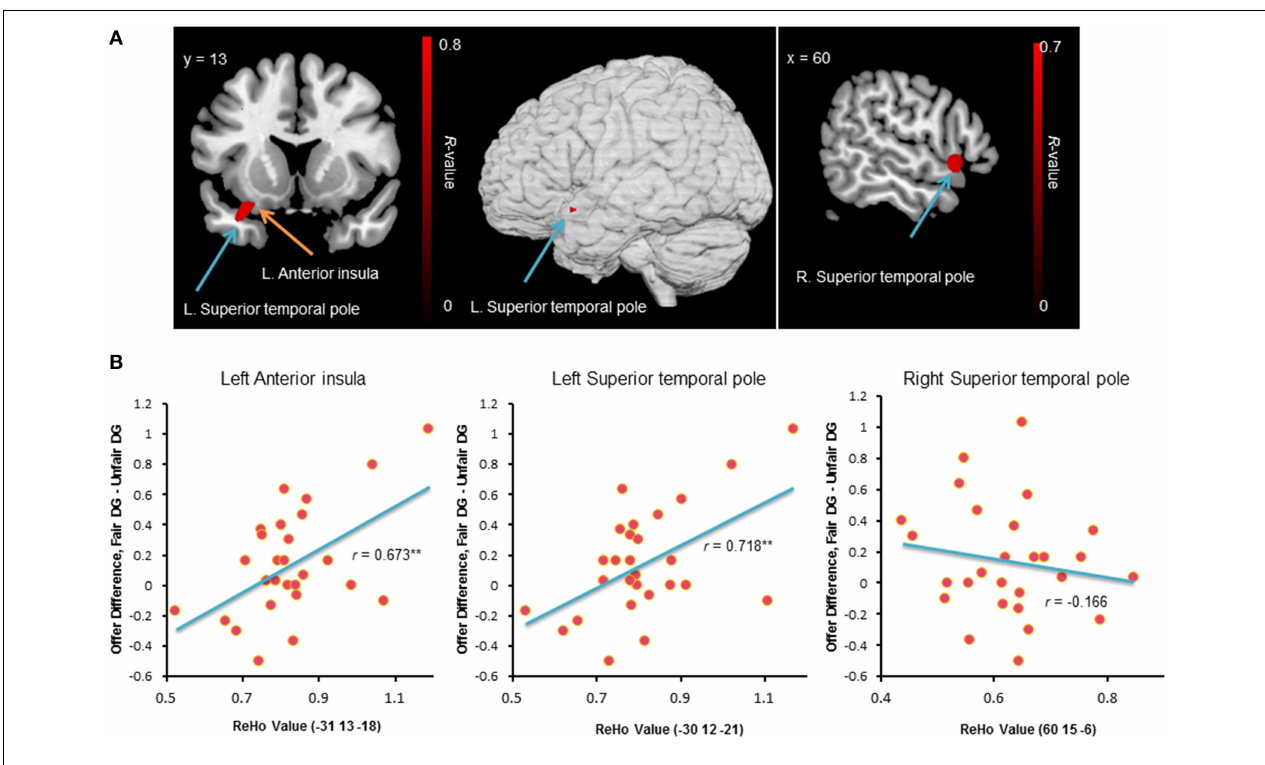
FIGURE 6 | Brain regions exhibited significant positive ReHo-behavioral correlations (A). An R -value scale is shown. The numbers above each image refer to the y-coordinates of the Montreal Neurological Institute (MNI). The threshold was set